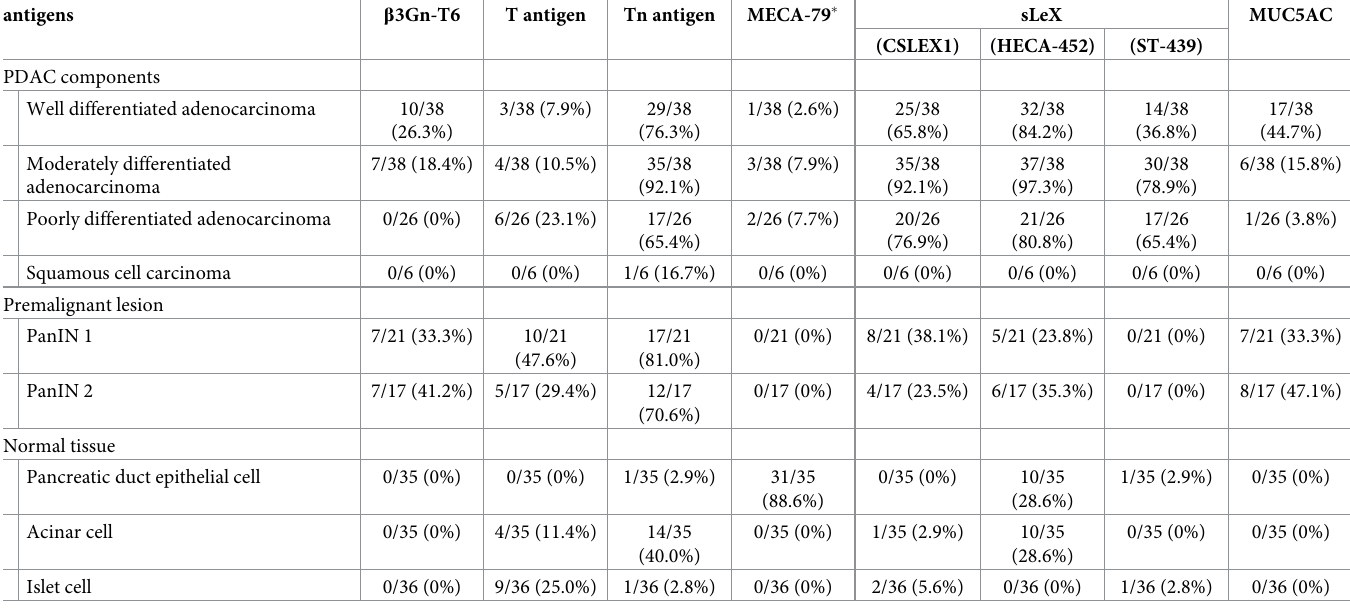
Table 3. Summary of glycan and its related antigen